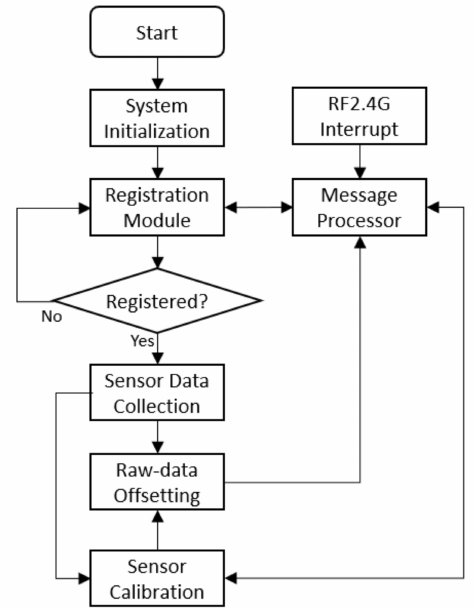
Figure 12. Software flowchart of sensor